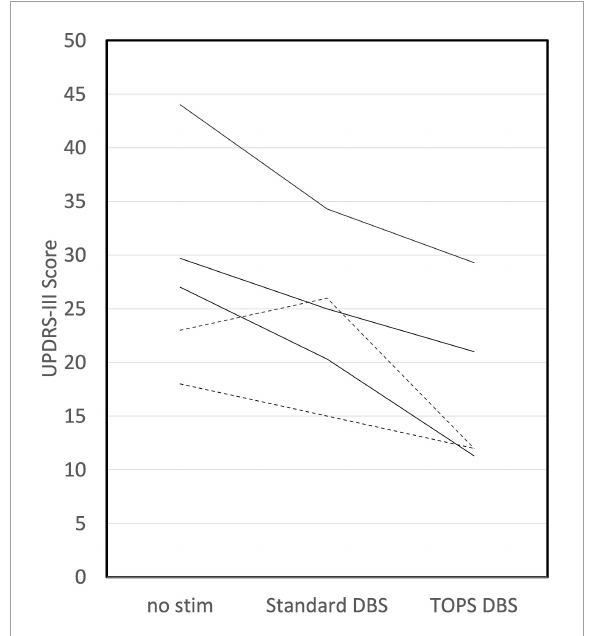
FIGURE3 TOPS DBS reduced UPDRS III (improved symptoms) more than standard DBS in 25% (5/20) of subjects. Dotted lines represent subjects in which TOPS1 was the most effective TOPS. Solid lines represent subjects in which TOPS2 was the most effective